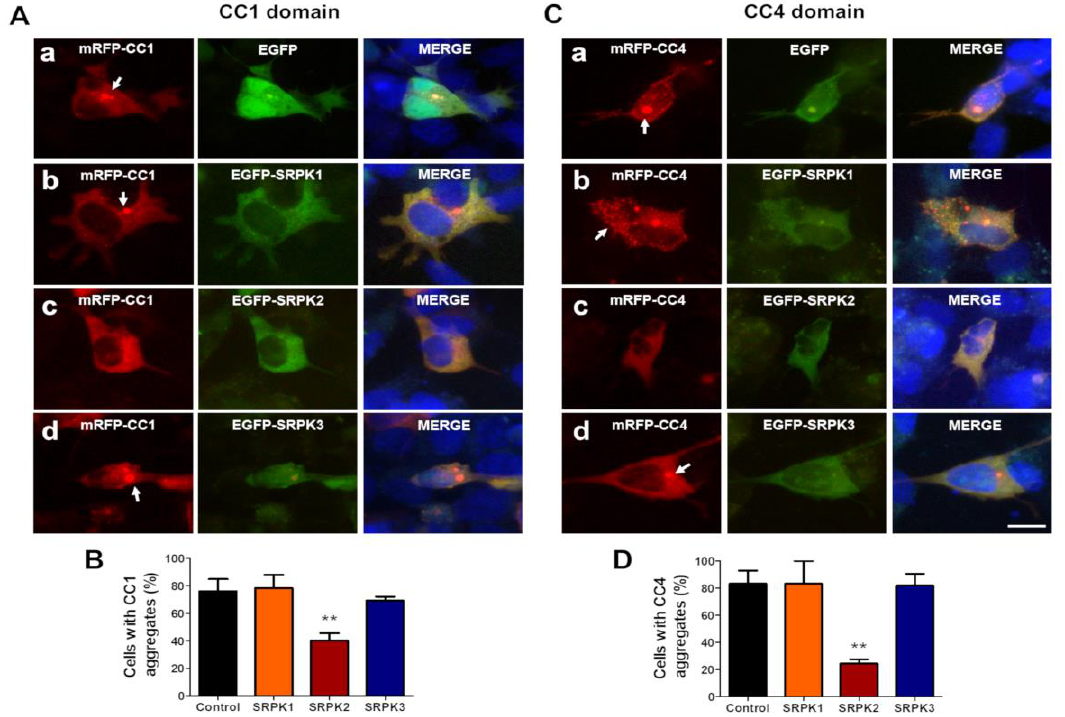
Figure 6. SRPK2 specifically disrupts the aggregation of CAST1 / ERC2 domains CC1 and CC4 in the neuroblastoma SH-SY5Y. Representative images of SH-SY5Y cells co-transfected with either EGFP (control) or EGFP-SRPK1, -2, -3 and mRFP-tagged ( A ) CC1 and ( C ) CC4 domain plasmids. Forty-eight hours later, the cells were fixed and analyzed by fluorescence microscopy. Graphs show the quantification of the percentage of cells containing ( B ) CC1 and ( D ) CC4 aggregates. The plasmid amounts used for transfection of a 24-well plate were 0.8 and 0.6 µ g / well for CC1 and CC4, respectively. In the case of SRPKs the plasmid amount used for transfection was 1.0 µ g / well. Data are presented as mean ± SEM and statistical analysis was done by ANOVA and Bonferroni’s post-hoc test; n = 100 cells. ** p < 0.01 (three independent experiments). Errors bars represent SD. Scale bar: 10 µm.